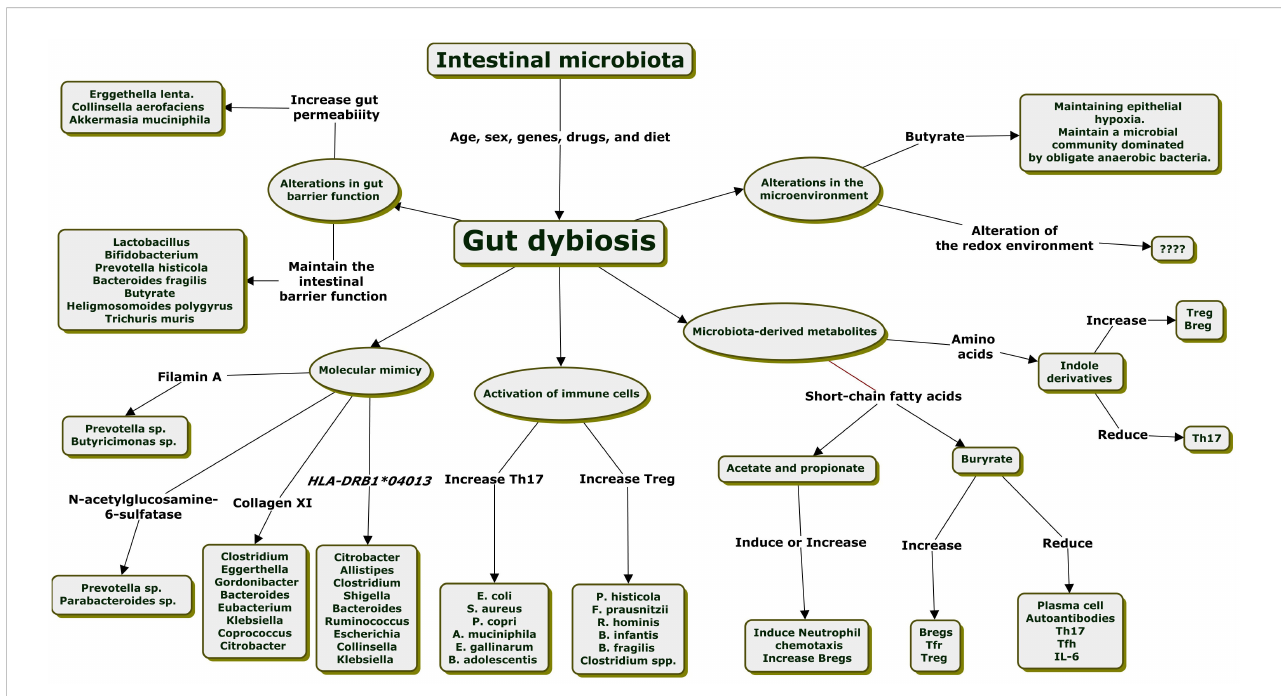
FIGURE 1 Mechanisms explained the relationship between intestinal dysbiosis and the development of rheumatoid